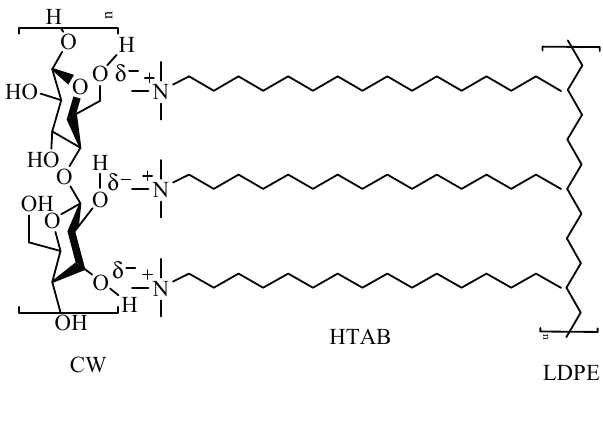
Figure 6. Suggested interactional structure for the LDPE/treated CW